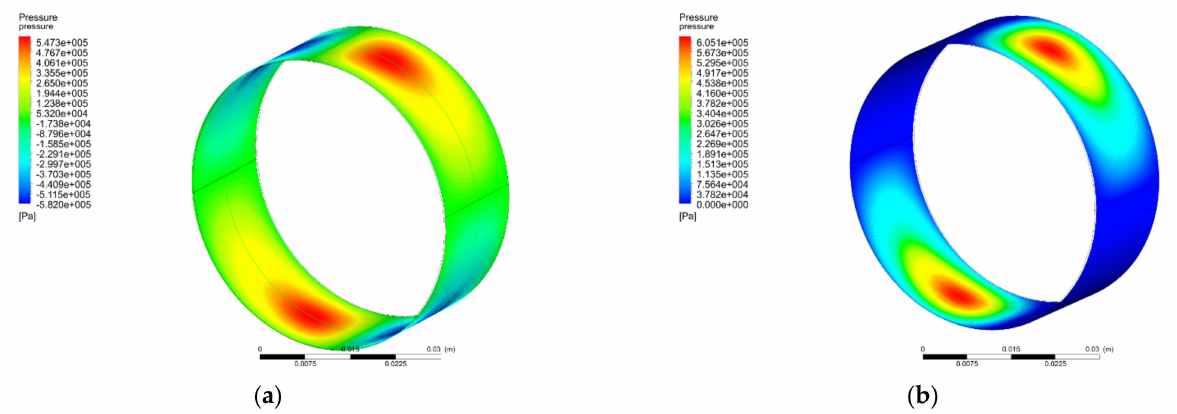
Figure 4. Pressure contour in Pa on the journal surface: ( a ) without applying half-Sommerfeld boundary condition, and ( b ) after applying half-Sommerfeld boundary condition when the film pressure is lower than the atmospheric